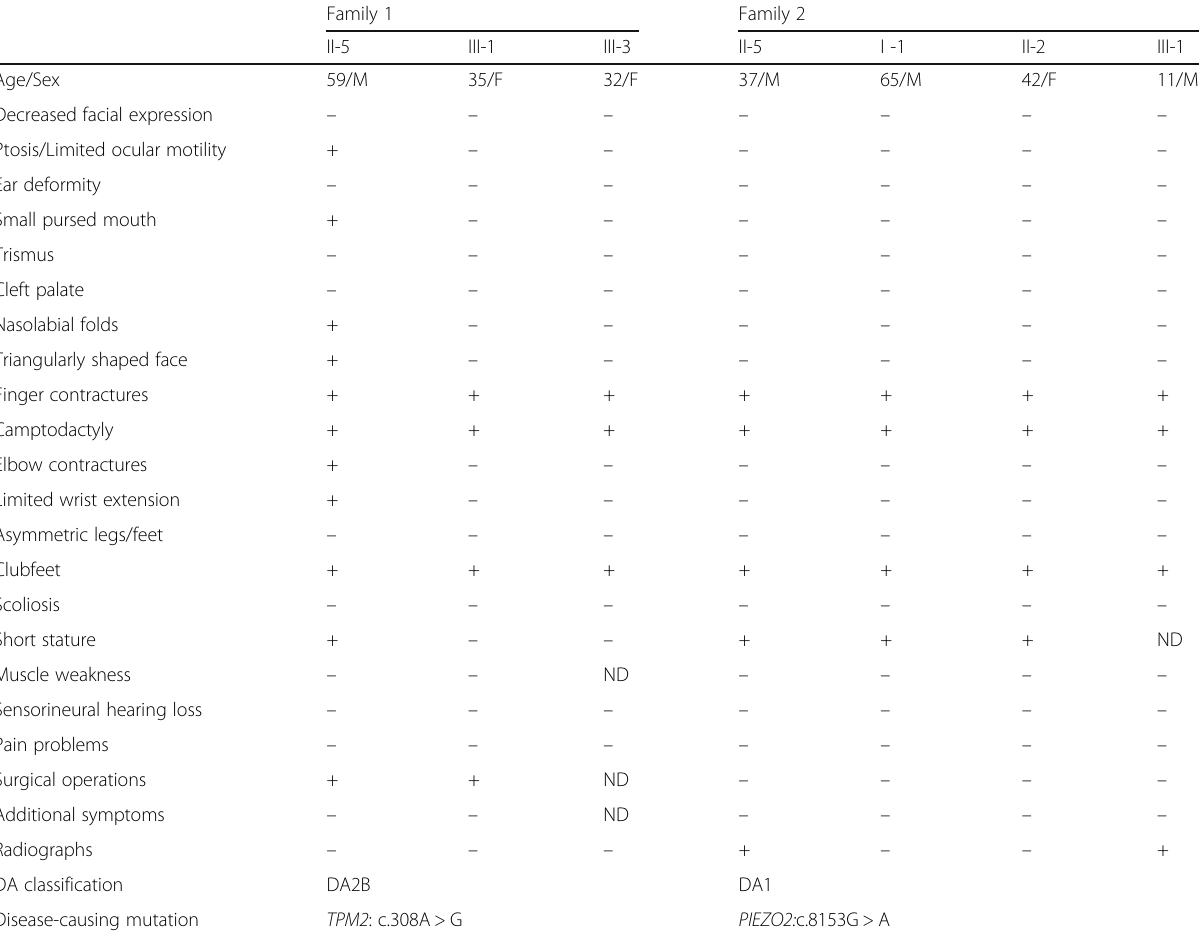
Table 1 Clinical phenotypes of patients with TPM2 and PIEZO2 gene mutations in two